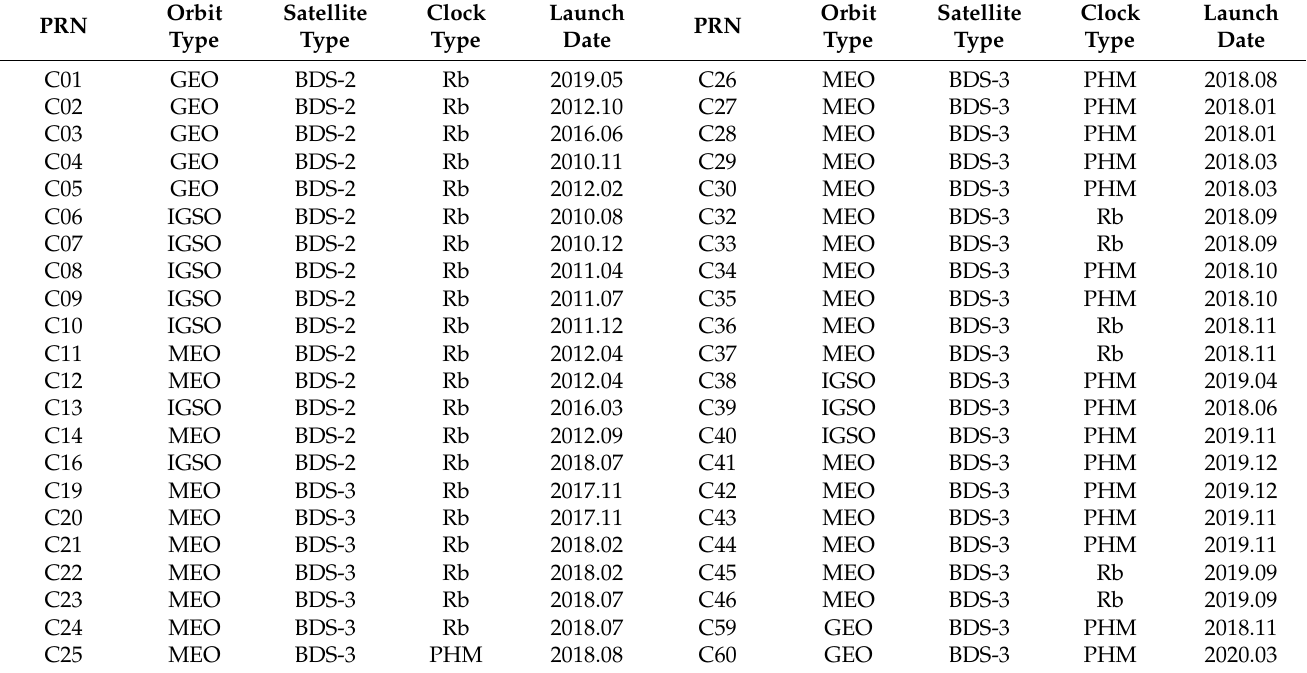
Table 1. Information about BDS-2/3 satellites and